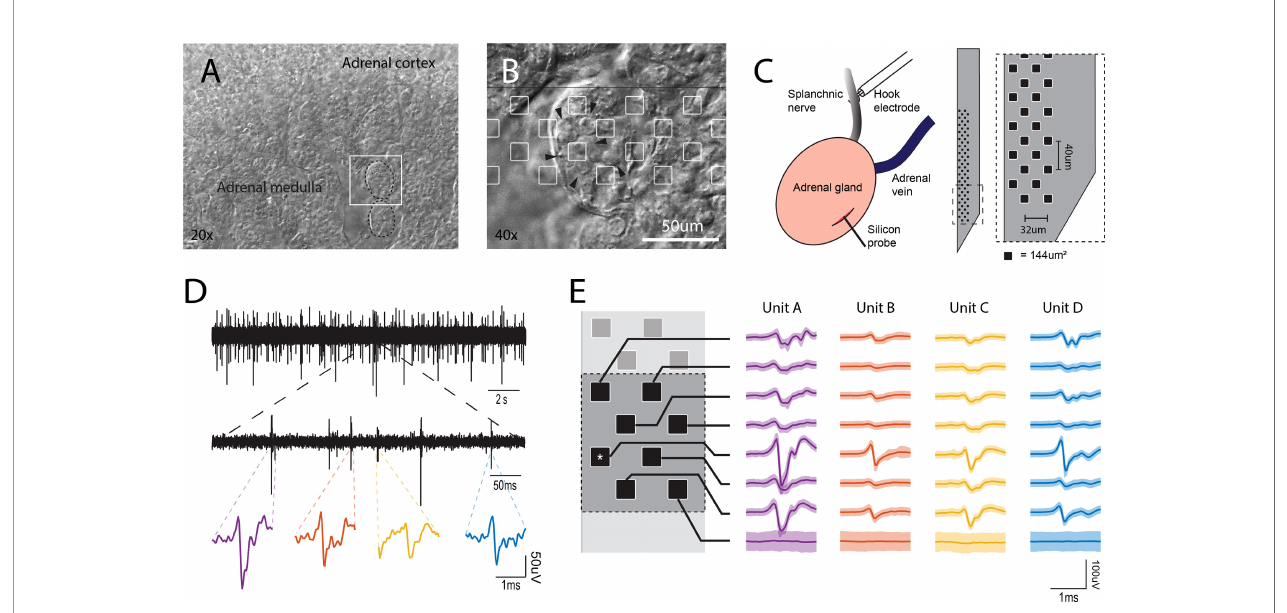
FIGURE 1 | In vivo electrophysiological recordings from the intact adrenal medulla. (A) Low power bright fi eld micrograph showing the adrenal cortex and the adrenal medulla. The white square represents the area shown in panel (B) B. Bright fi eld micrograph showing the clustered architecture of the adrenal medulla (arrowhead = individual chromaf fi n cell). The silicon probe layout is shown in scale with the tissue, recording sites are presented as white squares. (C) Left, preparation in the anesthetized rat for simultaneous stimulation to the splanchnic nerve and the recording of the electrical activity in the adrenal medulla. Right, 64 channel silicon probe layout covering an area of 48x620 um (0.02976 mm 2 ), the area of each individual recording site is 144µm 2 . (D) Spontaneous extracellular action potentials. Shown are recordings at low, medium and high expanded time scales. The most expanded recordings (bottom traces) show the waveforms of individual events. (E) A cell ’ s action potential projects distinct waveforms depending on its position to each recording site in the neighborhood (the asterisk represents the channel shown in (D) , the set of these slightly different waveforms de fi ne a unit ’ s template and it is unique for each cell (solid line ±